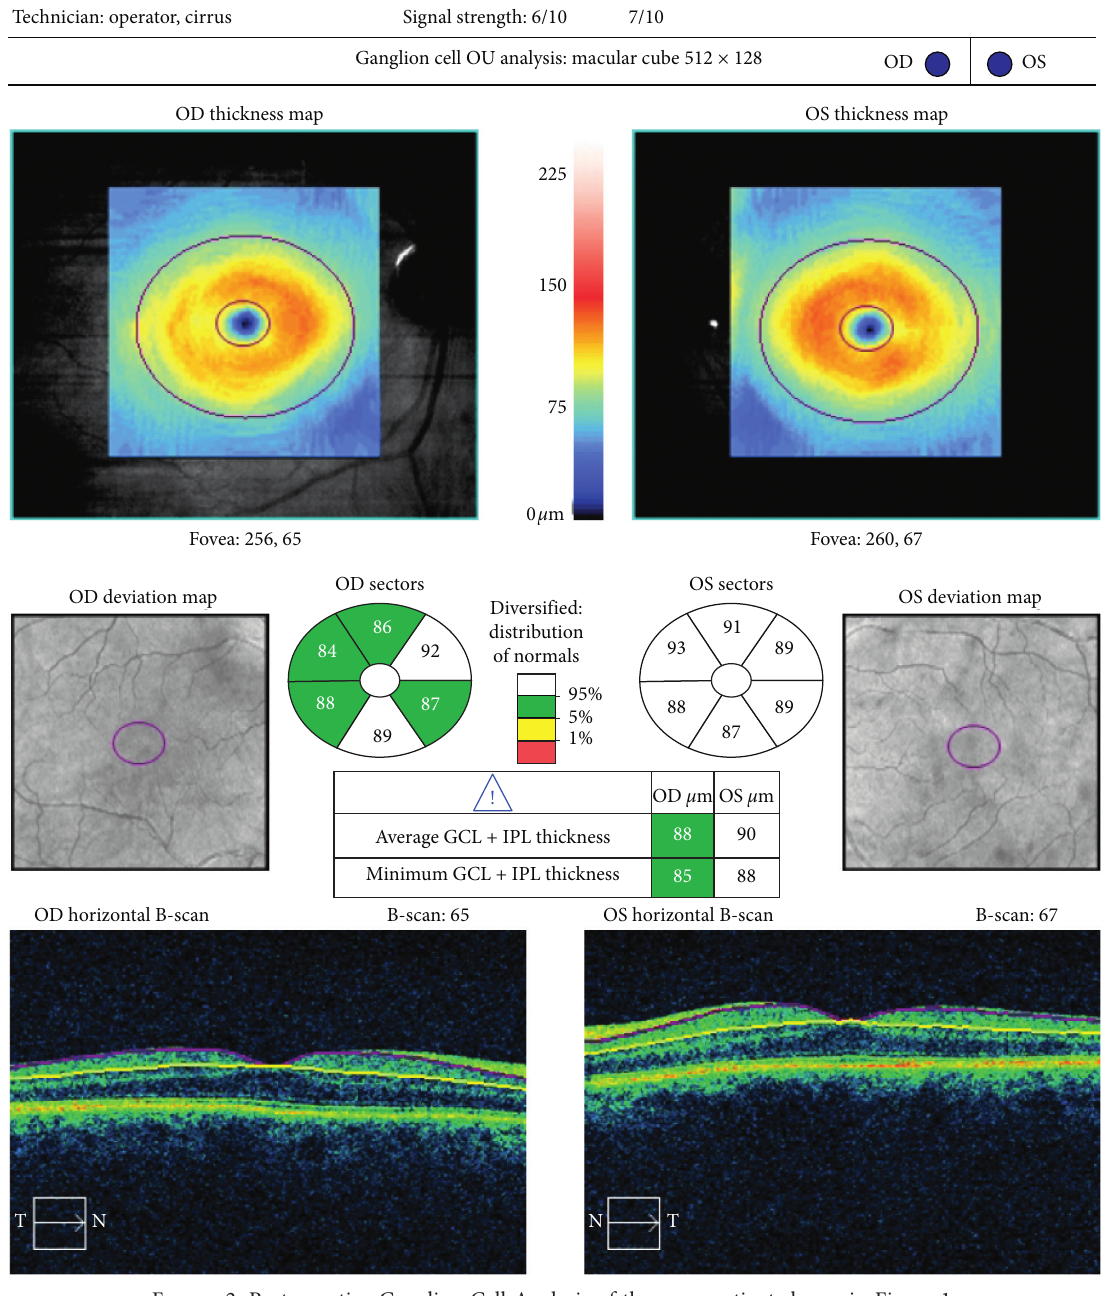
Figure 2: Postoperative Ganglion Cell Analysis of the same patient shown in Figure